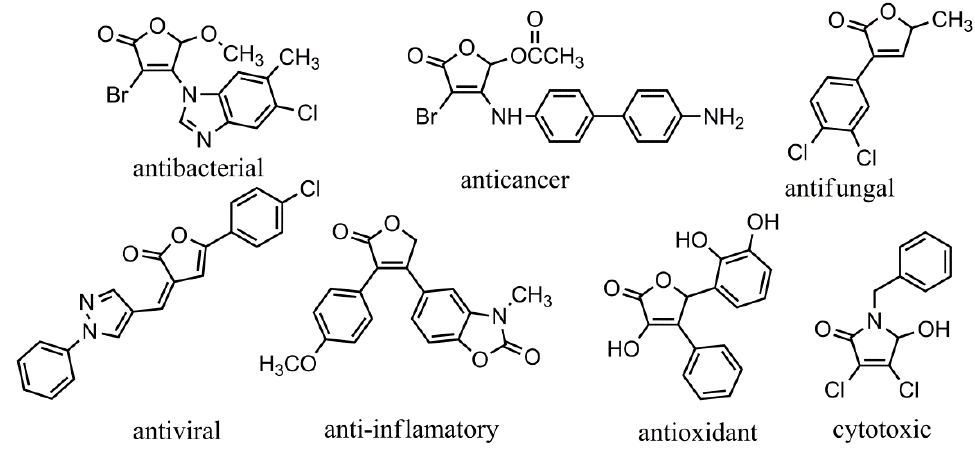
Figure 1. The structures of the structures based on furan-2(5 H )-one and 2 H -pyrrol-2-one with known biological activity.